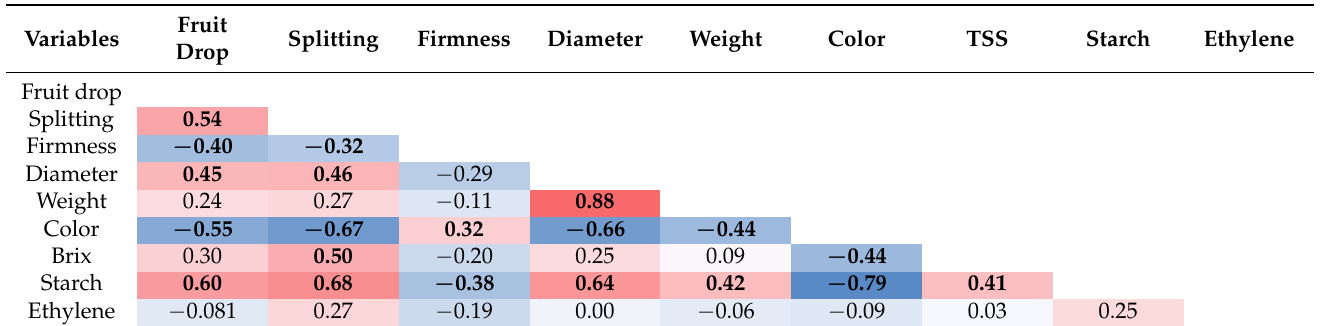
Table 5. Pearson’s correlation between fruit morphology traits at harvest in ‘Crimson Gala’ apples, 2021, Exp.